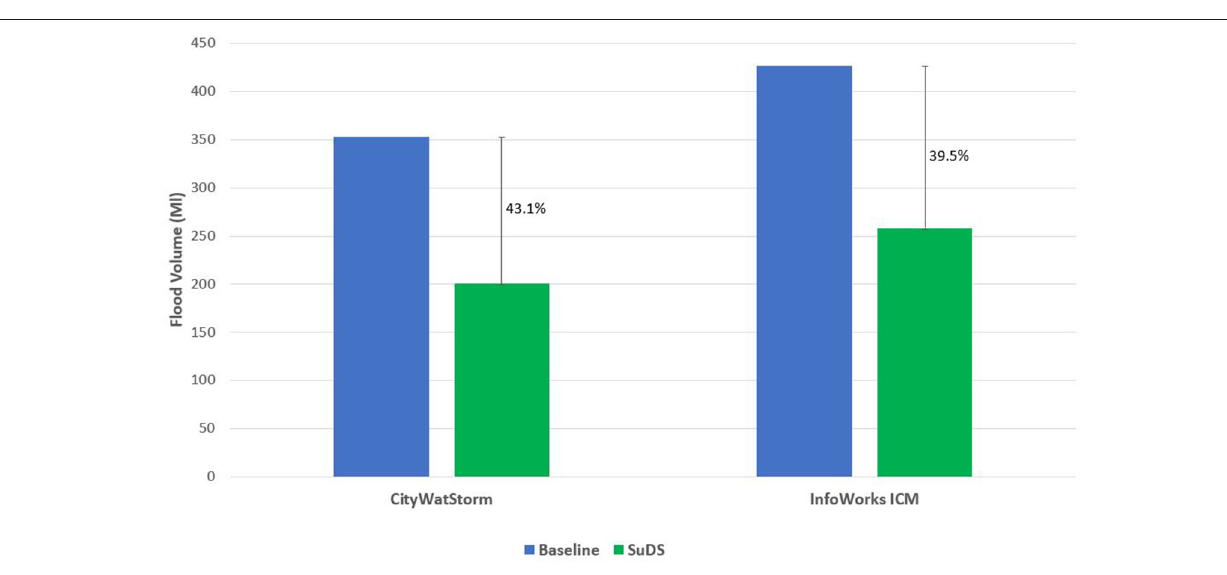
FIGURE 7 | SuDS implementation - Flood volume